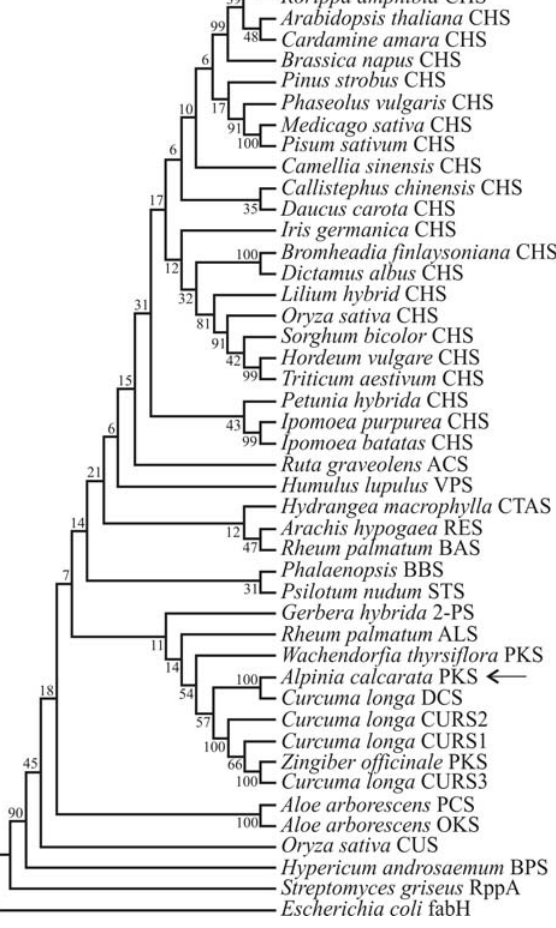
Figure 2 - Phylogenetic analysis of AcPKS with other members of PKS superfamily, using the NJ method implemented in MEGA 3 and 1000 bootstrap replicates. The AcPKS identified in this study is marked by an arrow. It forms a cluster with members of the nonchalcone forming